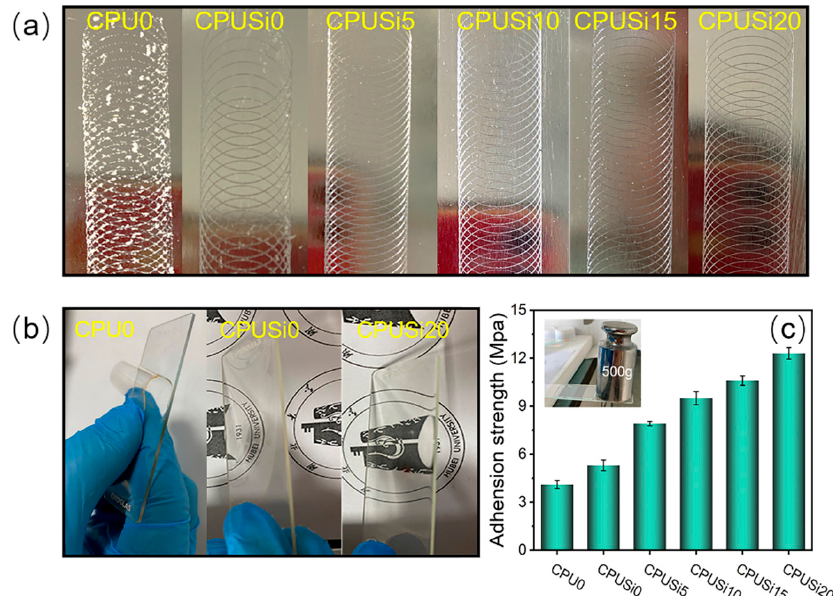
Figure 10. ( a ) Photos of the object behind the circle; ( b ) Photos of the object after boiling at high temperature; ( c ) The lap shear strength of CPU and CPUSi.